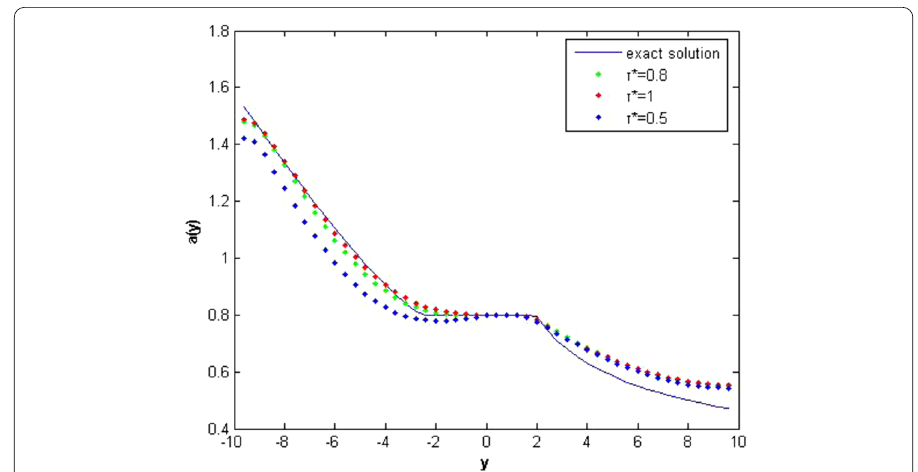
Figure 1 Identified drifts for Example